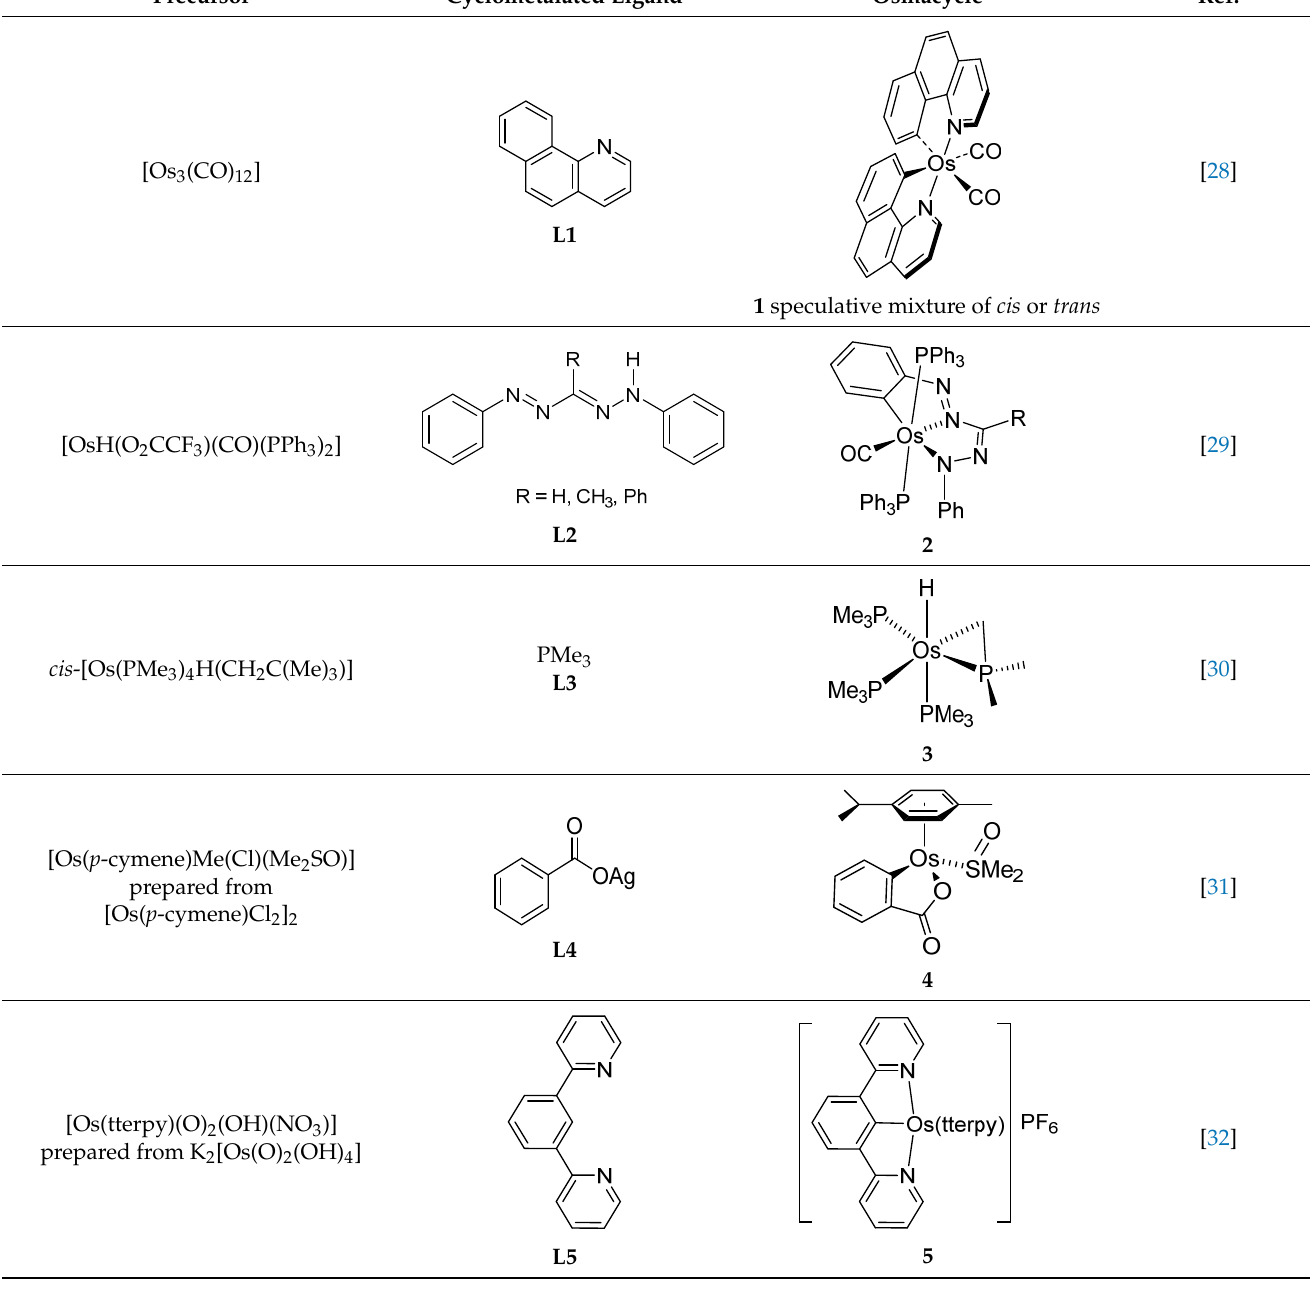
Table 1. First osmacycles prepared between 1973 and 1997.